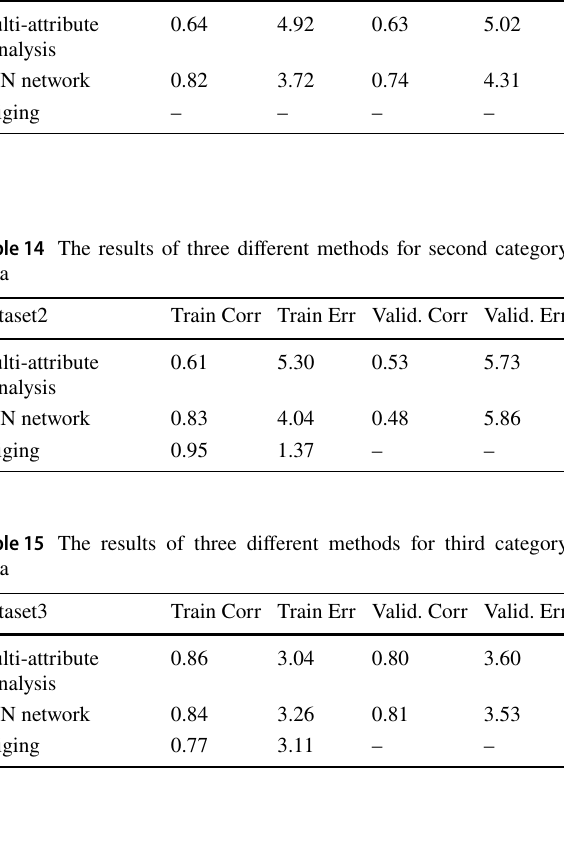
Table 13 The results of three different methods for first category data Dataset1